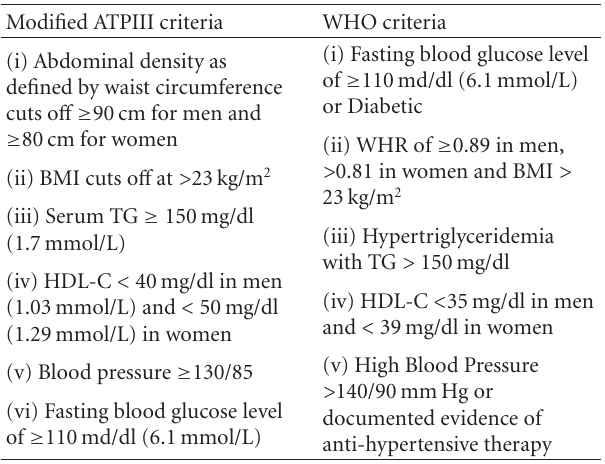
Table 1: Metabolic syndrome: diagnostic criteria. Modified ATPIII